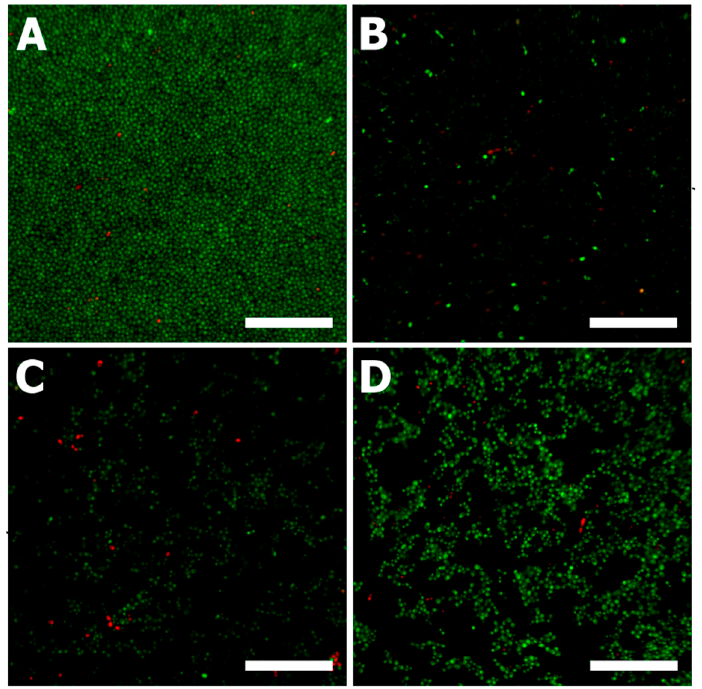
Figure 4. Imaging of C. albicans DBM 2164 biofilm by confocal microscopy with rotating discs. Control ( A ), 100 mg/L of resveratrol in blue grape extract ( B ), 10 mg/L of resveratrol in cane extract ( C ), 100 mg/L pure resveratrol ( D ); scale bar 400 µm.